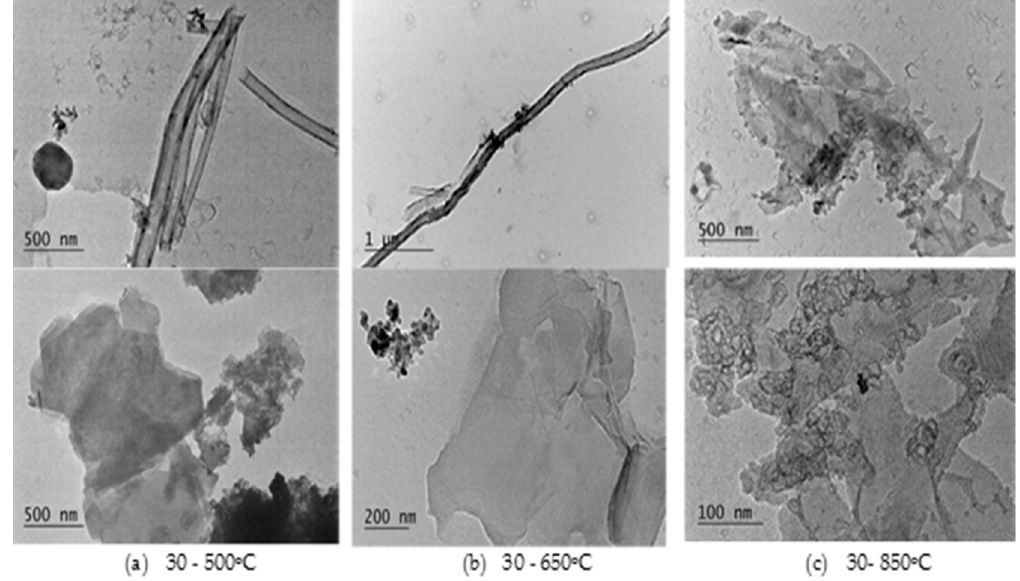
Figure 4. TEM micrographs of MWCNTs (first line) and GNPs (second line) observed in the residue ash at the three decomposition temperatures: ( a ) 500 °C, ( b ) 650 °C and ( c ) 850 °C in air atmosphere.